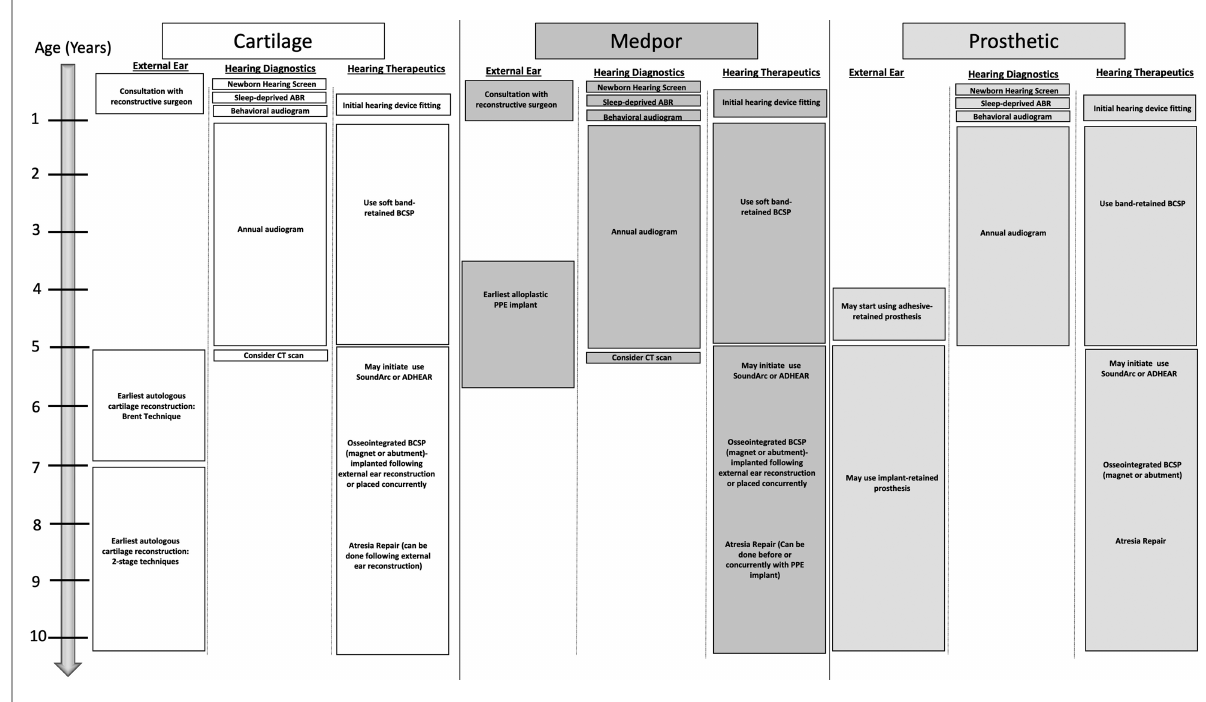
FIGURE 11 Recommended timing of key events for the hearing management and reconstruction of microtia and aural